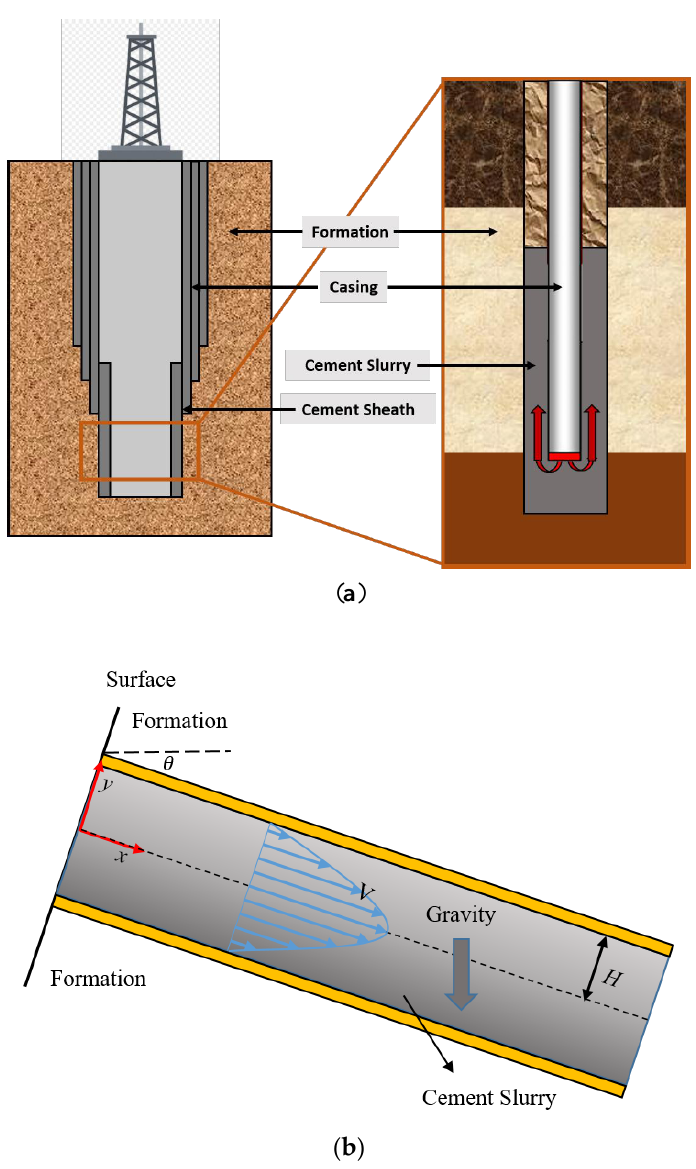
Figure 2. Schematic diagram of ( a ) oil well cementing and ( b ) cement slurry flow in a tilted channel.